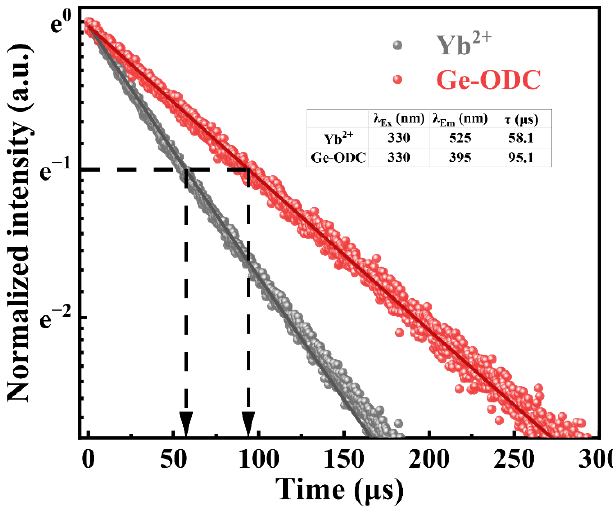
Figure 3. Fluorescence decay curves of Yb 2+ ions and Ge-ODC.